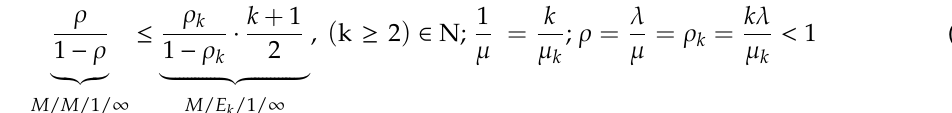
3 of 12 Figure 1. Flow diagram of the M/E r /r current solution.